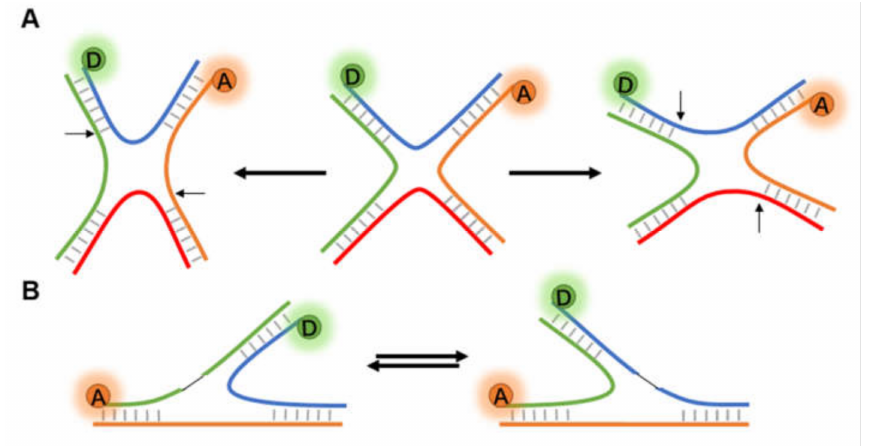
Figure 6. Structural change of Holliday junctions. ( A ) The diastolic four-way Holliday junction changes to either potentially compact X structures in the presence of cations or other accelerant. ( B ) Two different conformational isomers of three-way